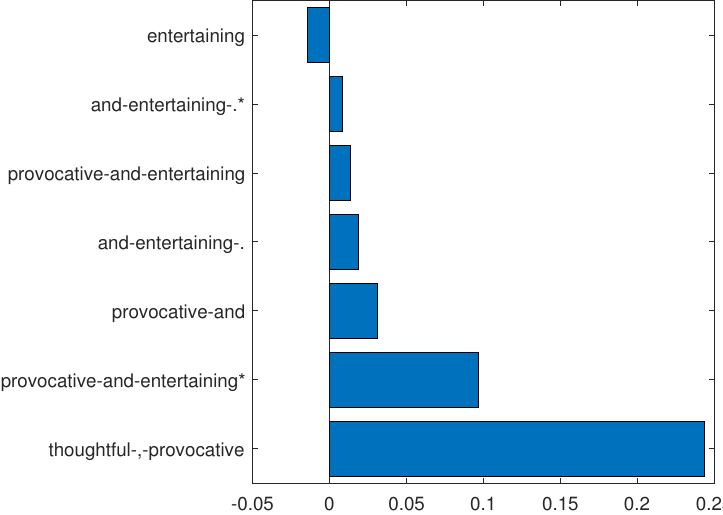
Figure 13. N-grams determined from R 24 and the following “tweet”: “thoughtful, provocative and entertaining”. The sum of the n-grams linear contributions is